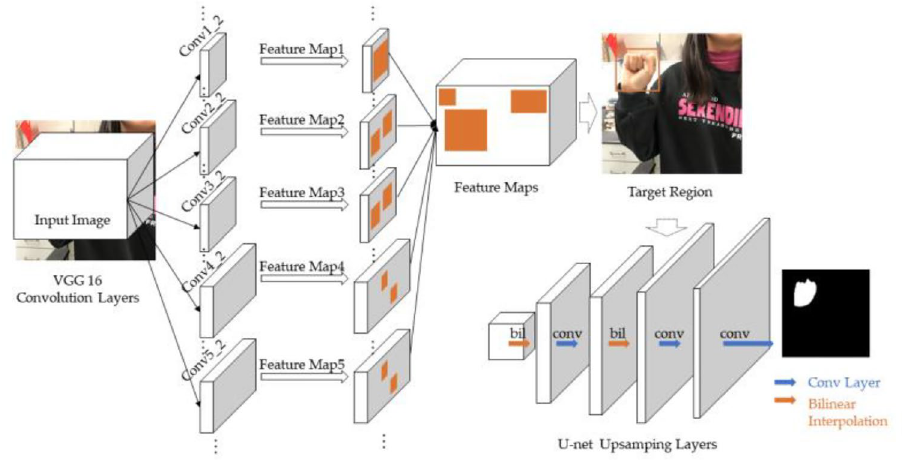
Fig. 2 Flowchart of VGG16 for feature extraction and U-net for